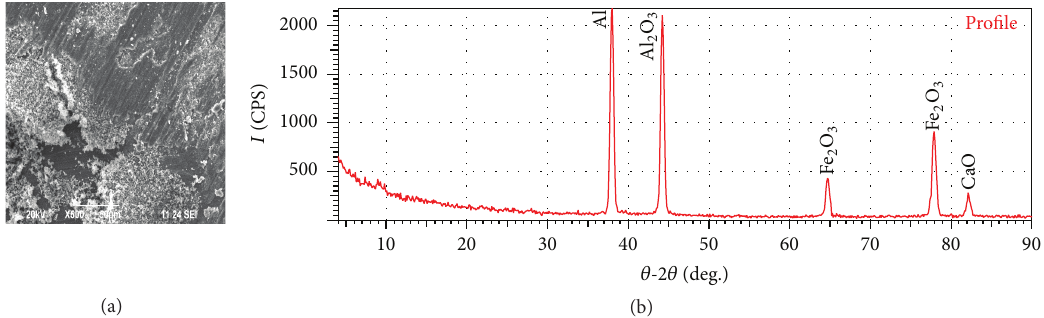
Figure 12: (a) SEM of worn surface of sample-III after running 3000 m at 29.43 N load and 4.71 m/s sliding speed. (b) XRD test report of the worn surface of sample-III.